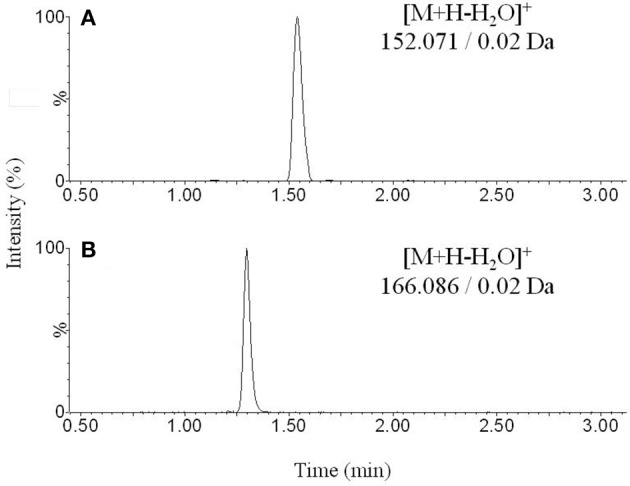
Representative chromatograms obtained from blank sample spiked with (A) norepinephrine and (B) normetanephrine.